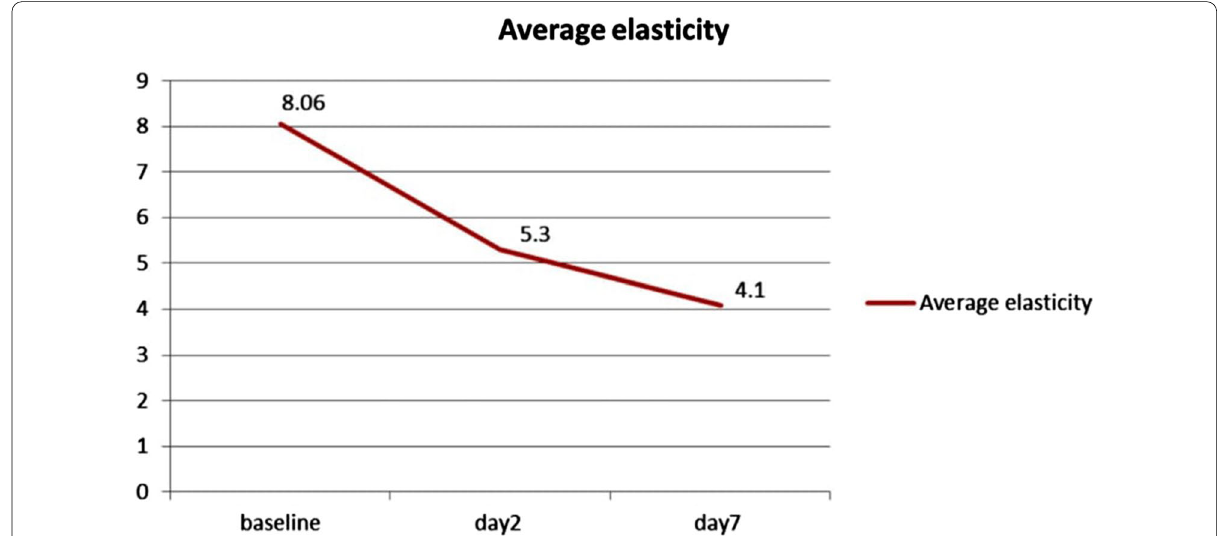
Fig. 1 Changes in the average liver elasticity over baseline (day 0), (day 2) and (day